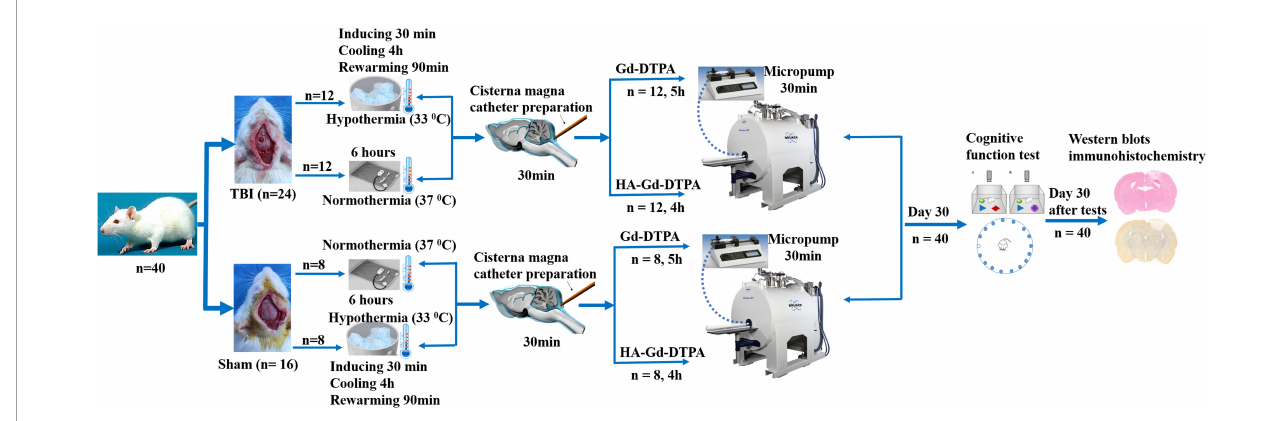
FIGURE1 Timeline schematic of the experimental layout where animals received TBI and sham surgery, were treated with hypothermia and normothermia, and were then imaged with intracisterna magna injection of low- and high-molecular-weight paramagnetic contrast